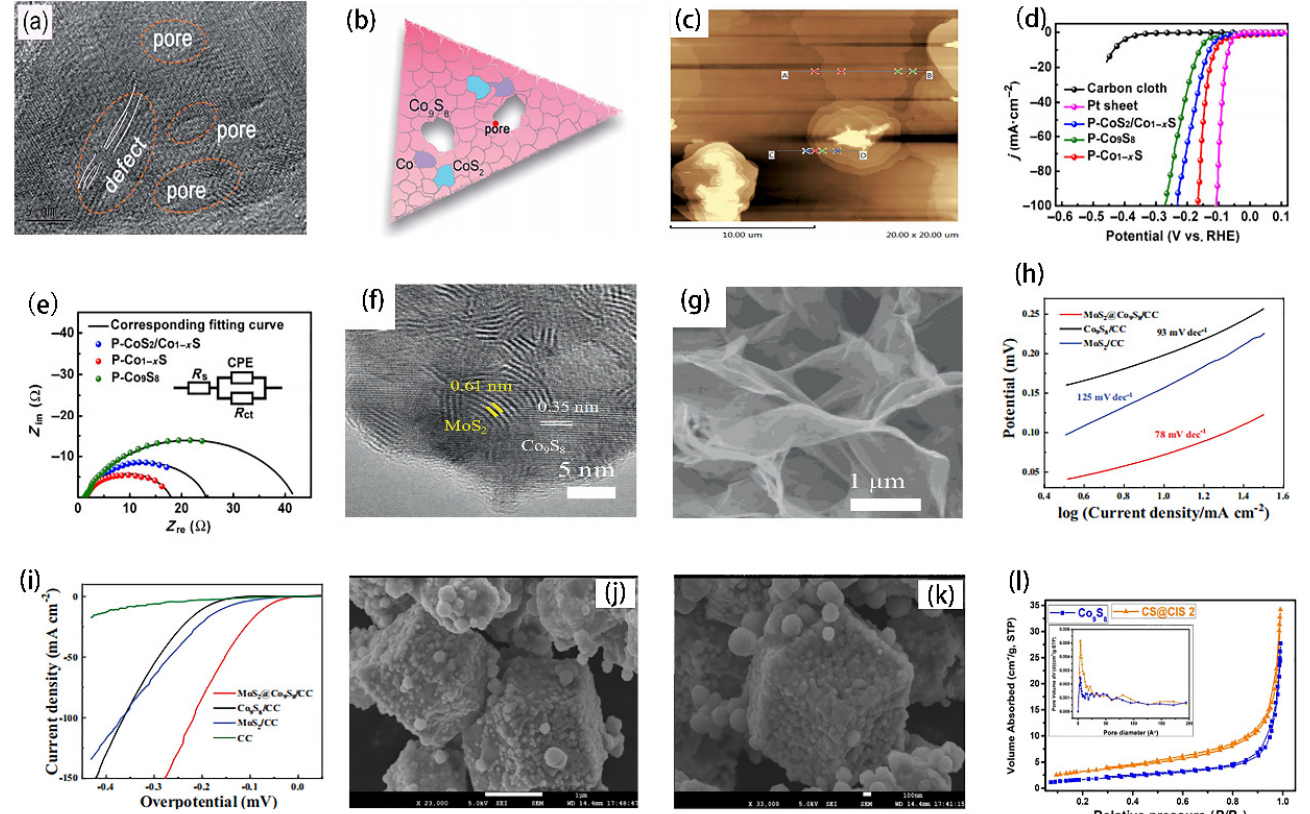
Figure 6. ( a ) HRTEM images of DR-Co 9 S 8 -II with pore defects and dislocation. ( b ) Schematic